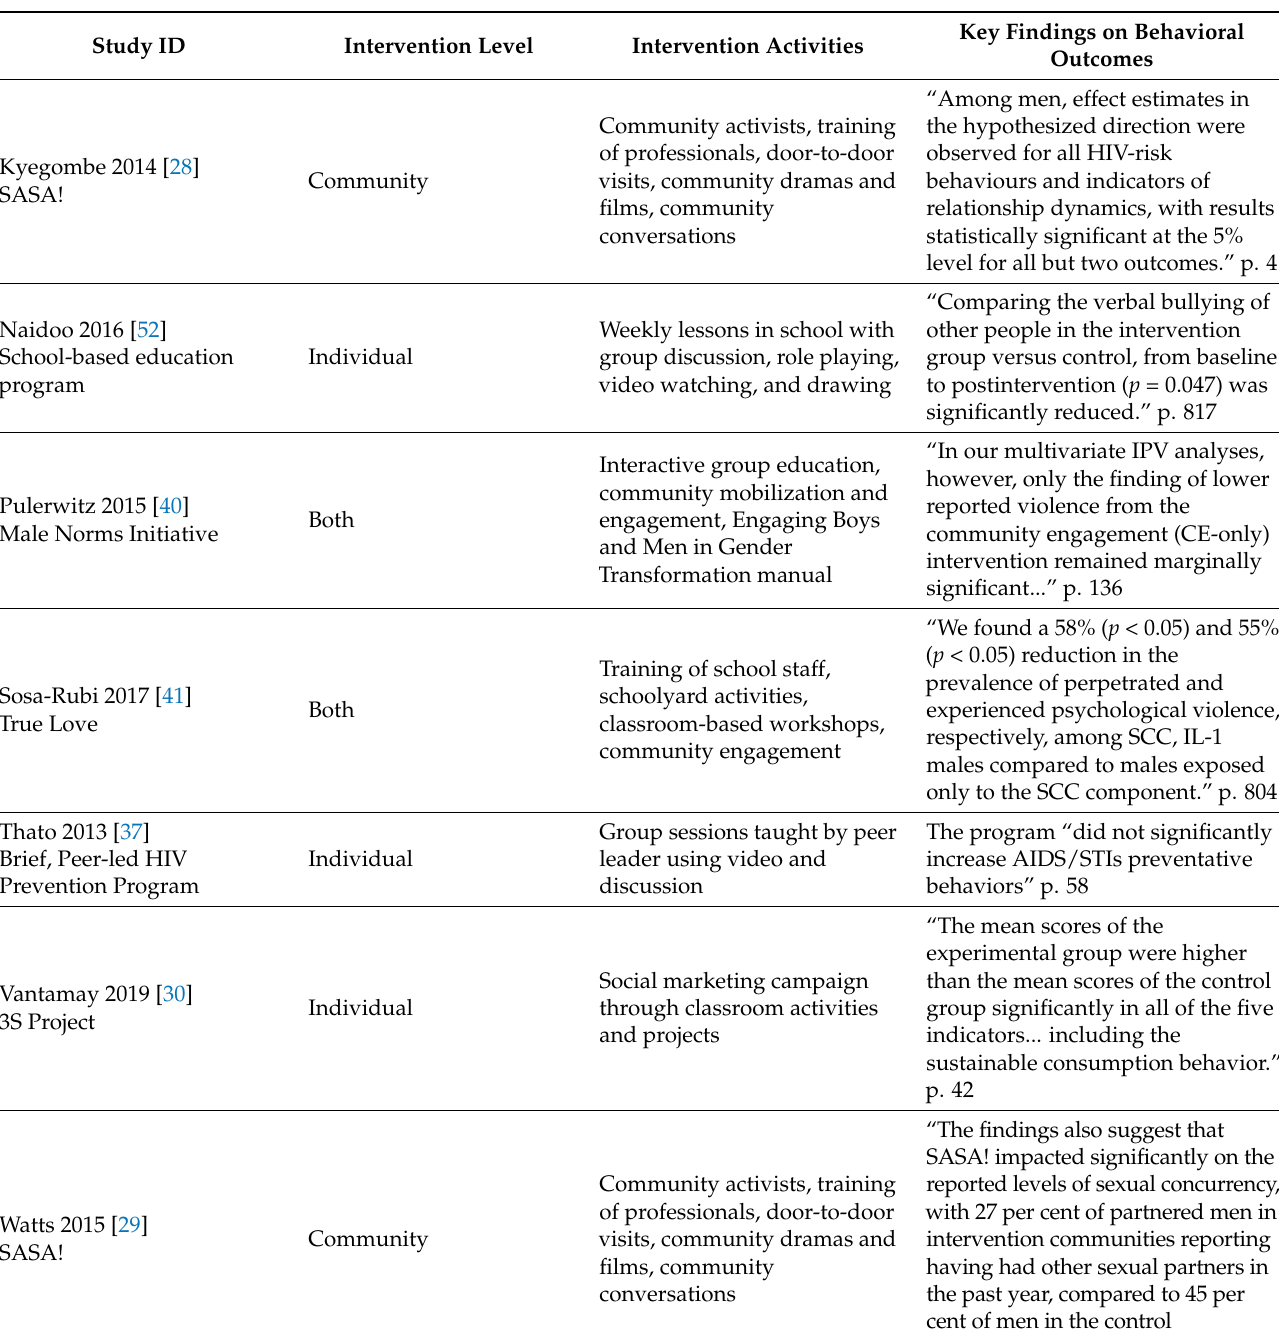
Table 4. Main findings on behavioral outcomes for primary studies assessed as having good confi- dence in the